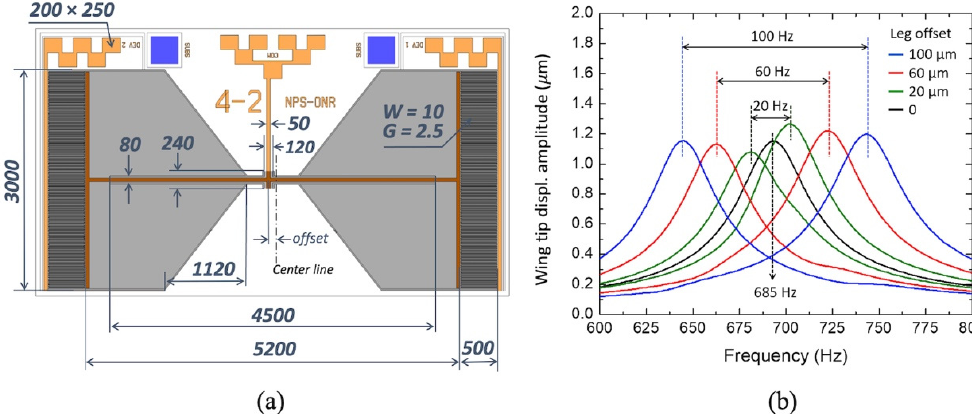
Figure 2. MEMS sensor design: ( a ) Schematic diagram of the design sensor with major dimensions (all dimensions are in micrometers). ( b ) Simulated mechanical sensitivity of the tip of the wings for the symmetric bridge and three different offsets. The peaks at higher frequencies are from the left wing (shorter bridge) and the peaks at lower frequencies are from the right wing (longer bridge).